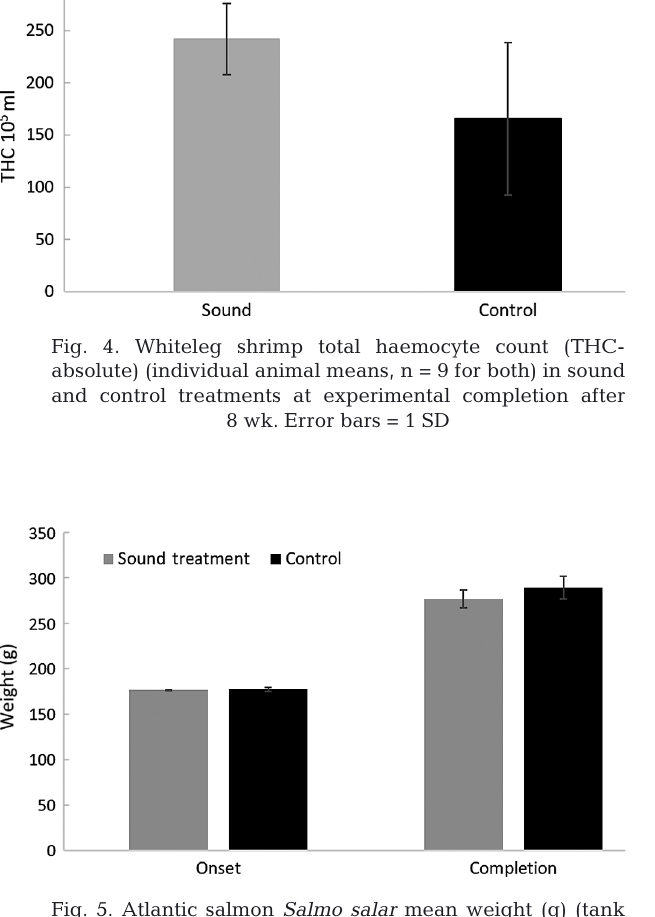
Fig. 5. Atlantic salmon Salmo salar mean weight (g) (tank means, n = 3) in sound and control treatments at experimental onset and at completion after 8 wk. Error bars = 1